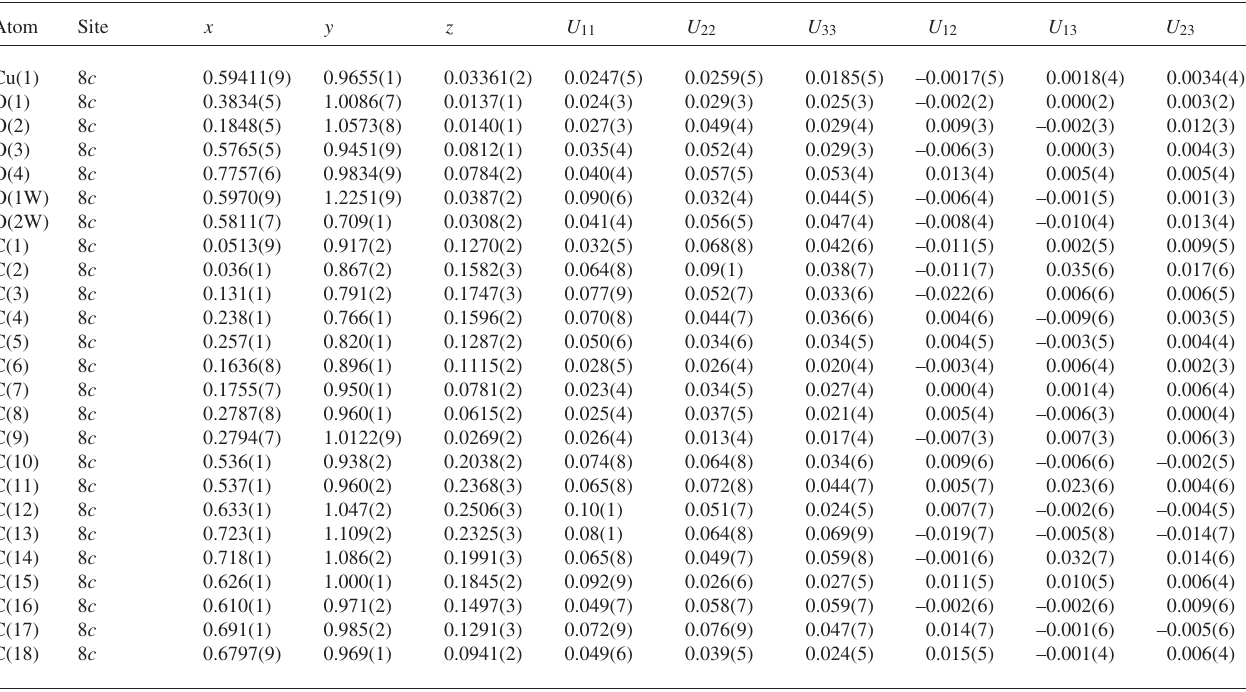
Table 3. Atomic coordinates and displacement parameters (in Å 2 )